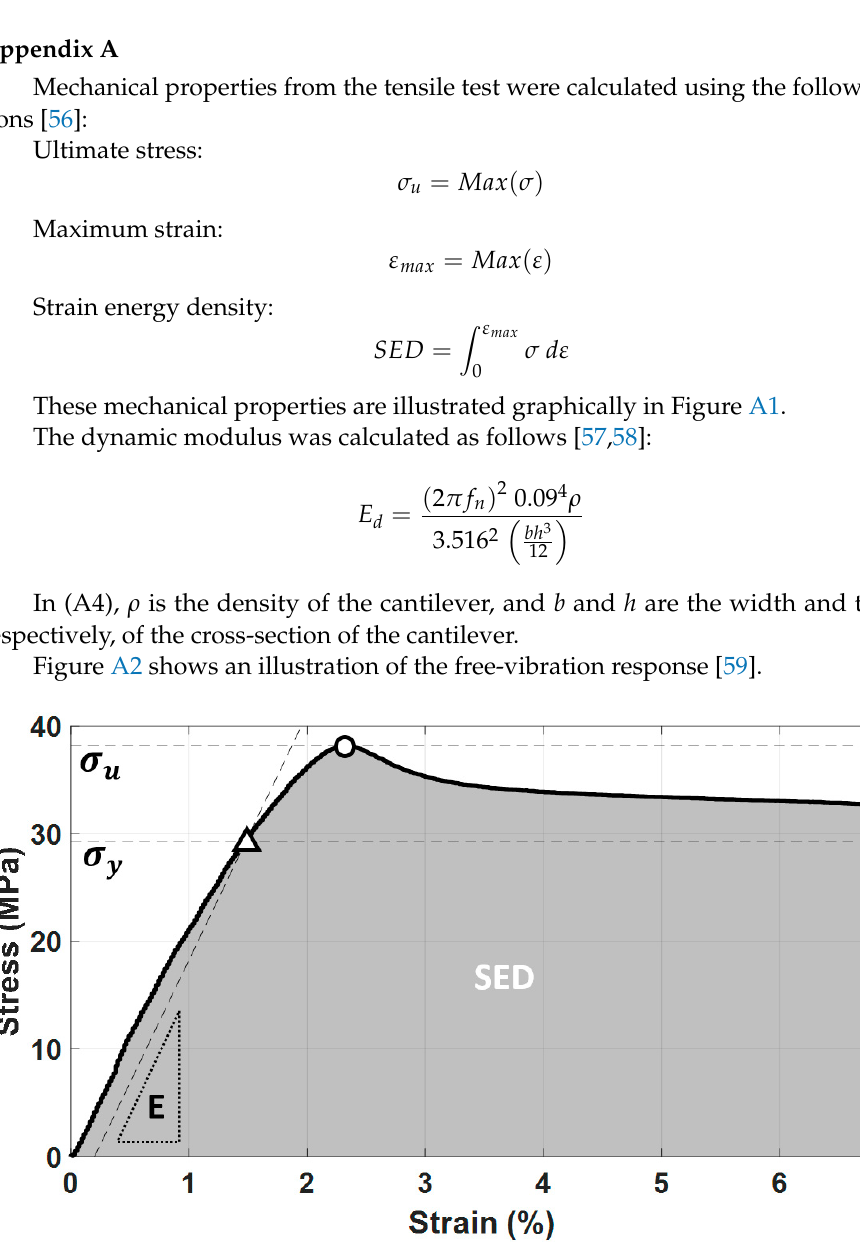
Figure A1. A representative stress–strain curve obtained from the tensile tests which were performed on the specimens reported in this work.